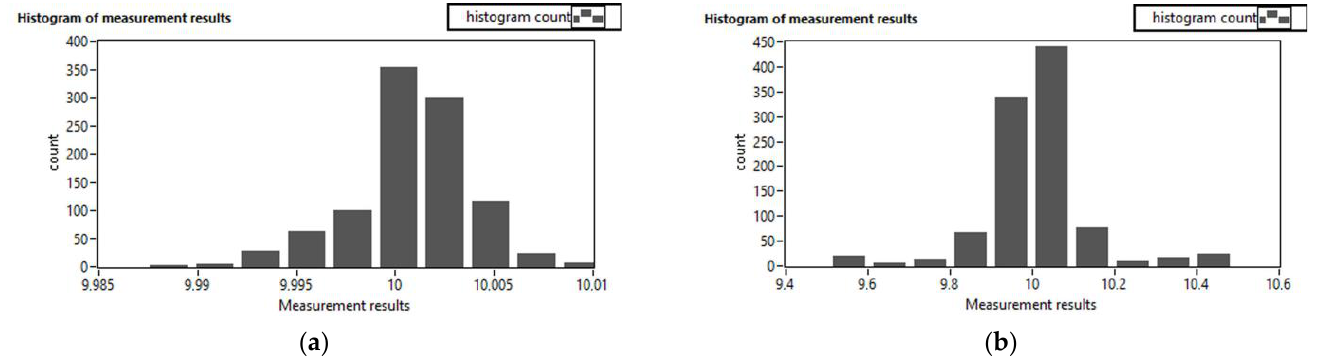
Figure 18. Histograms of individual results from a series of n = 1024 measurements made for the tested module NI USB-6001: ( a ) at low interference level, ( b ) at high interference level.